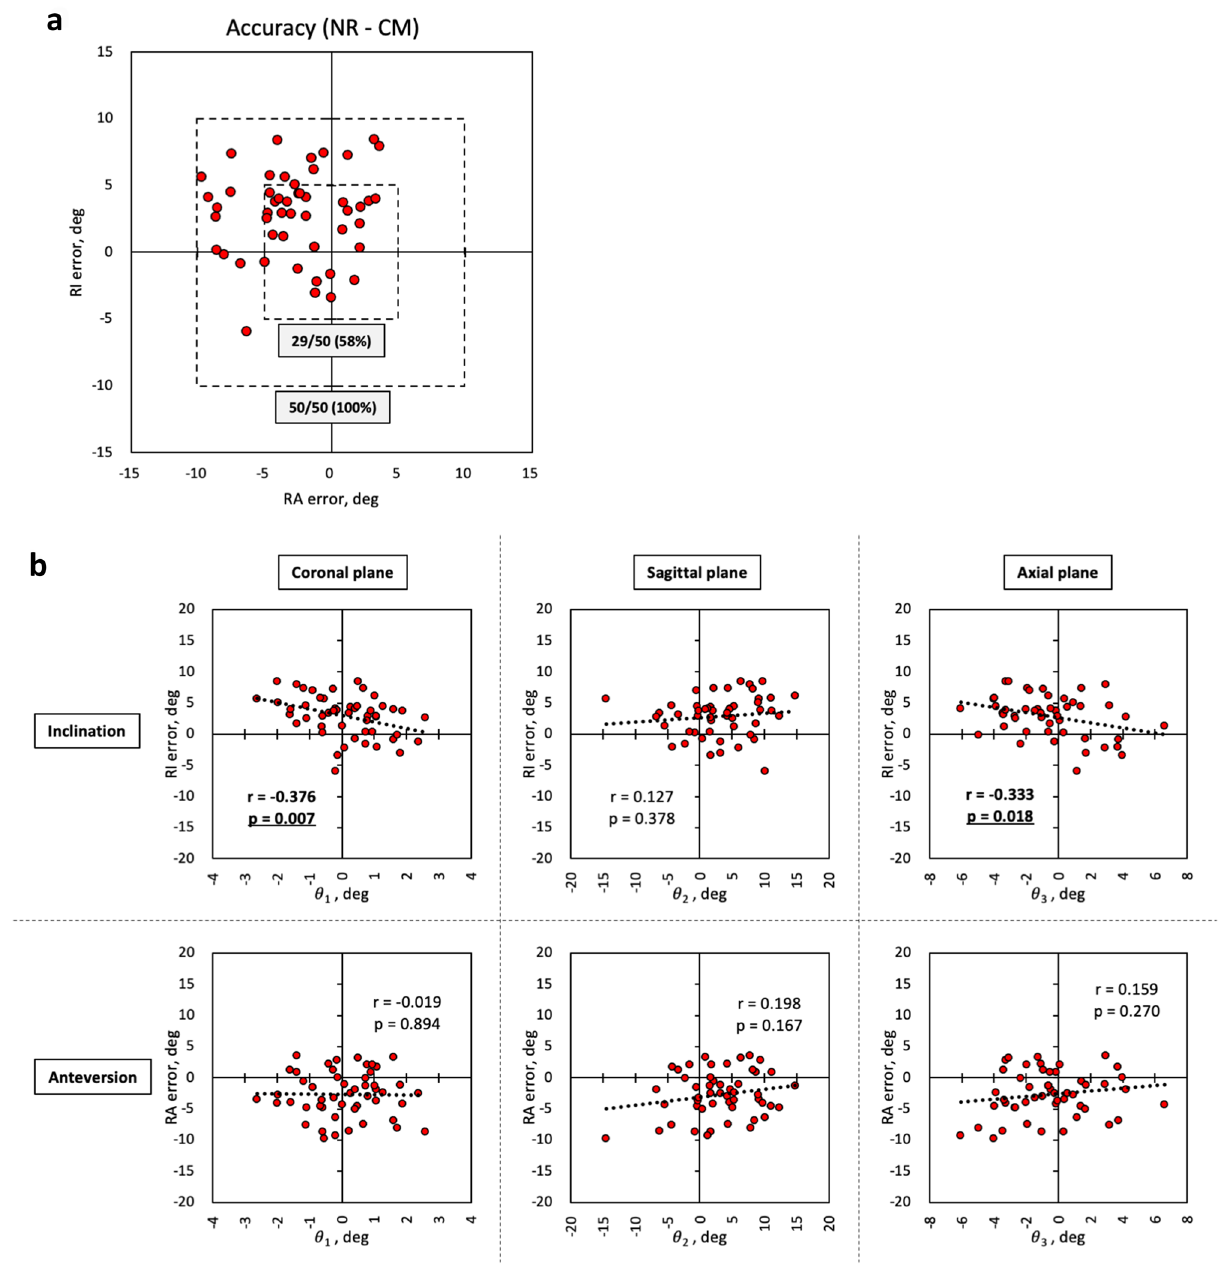
Figure 4. Accuracy when using the correction formula, and relationship between cup orientation error using correction formula and discrepancies in each pelvic tilt. ( a ) The actual accuracy of the portable accelerometer- based navigation system. The use of the correction formula clearly reduced the number of cases with large errors exceeding 5° or 10°. ( b ) The correlation diagram shows the relationship between the true RI/RA error and discrepancies in pelvic tilt in each plane. Since θ 1 and θ 2 were corrected, the correlation between the RI/ RA error and θ 2 in Fig. 2 disappeared. The uncorrected θ 3 remained correlated with RI error. r is the correlation coefficient. NR , navigation record; CM, CT measurement; RI, radiographic inclination; RA, radiographic anteversion; θ 1 , discrepancy in coronal pelvic tilt; θ 2 , discrepancy in sagittal pelvic tilt; θ 3 , discrepancy in axial pelvic